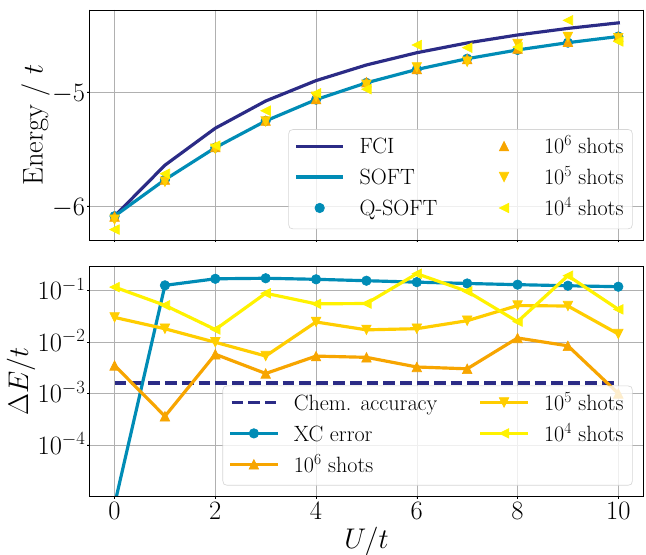
Figure 4: Top panel: Ground-state energy of the inhomogeneous one-dimensional Hubbard model as a function of the interaction strength U / t , in units of t . Bottom panel: Absolute error between Q-SOFT and SOFT energies when sampling noise is considered. They are compared to the chemical accuracy and the